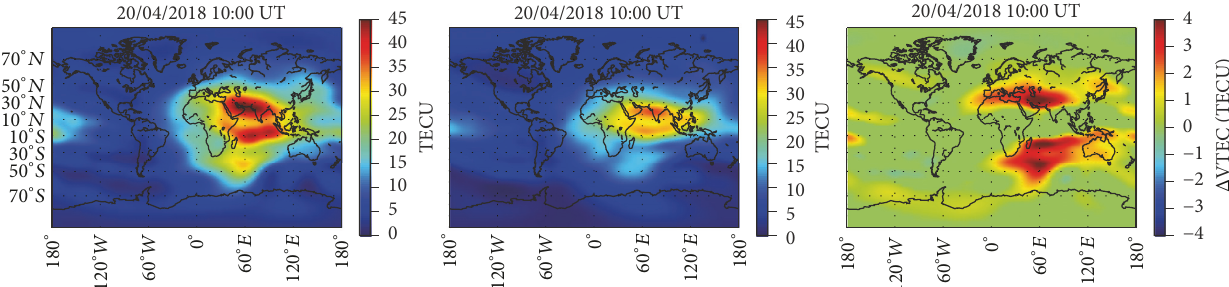
Figure 2: Left: GIM for April 20, 2018 at 10:00 UT. Center: map of the mean ( 𝜇 ) VTEC for April 20, 2018, at 10:00 UT. Right: differential VTEC map for April 20, 2018, at 10:00 UT.